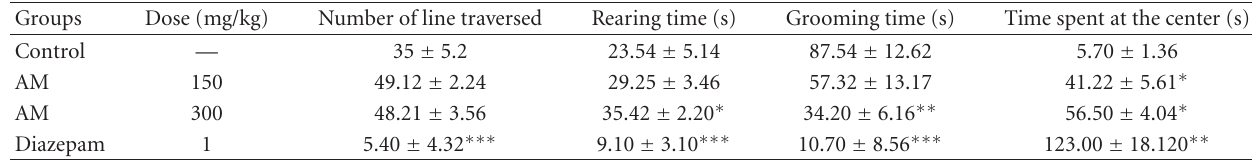
Table 1: E ff ects of the aqueous extract of A. multiflora stem bark and diazepam in the open field test in mice. Groups